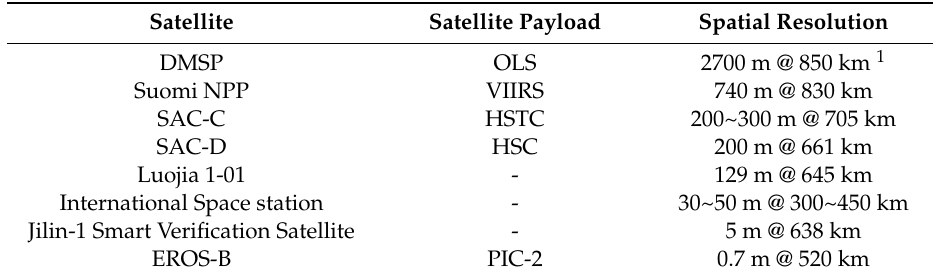
Table 1. Spatial resolution of existing night-light remote sensing